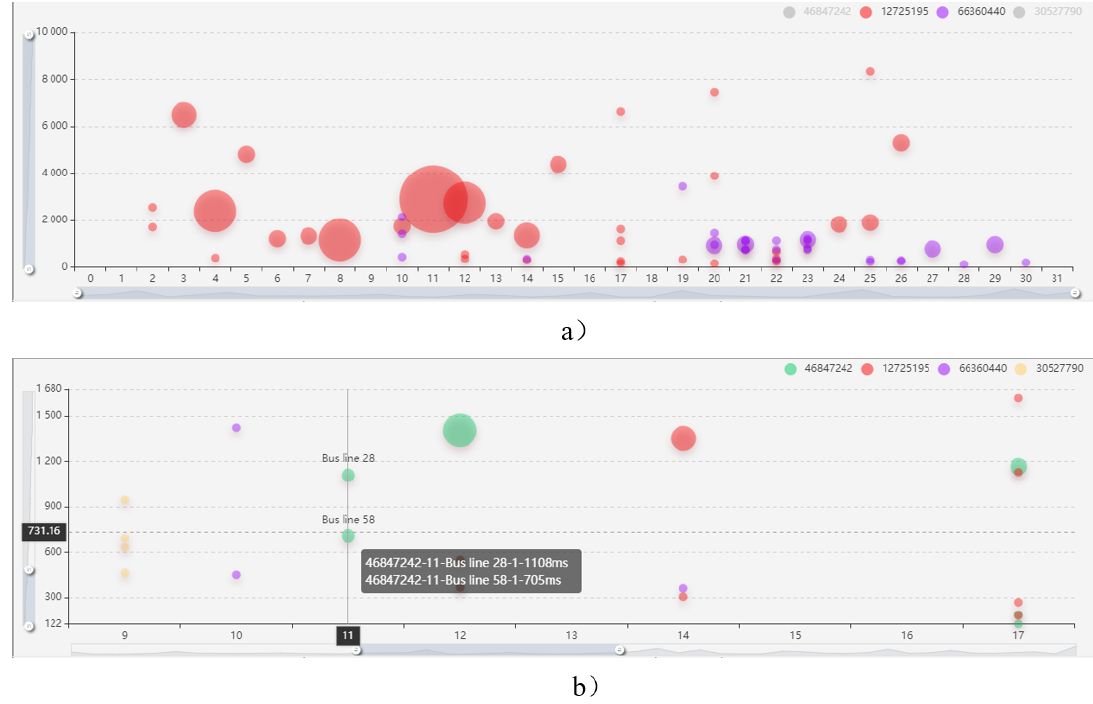
Figure 10. Bubble view interaction operation ( a ) Bubble view display and hidden, ( b ) Bubble view zoom in, zoom out and other interactive